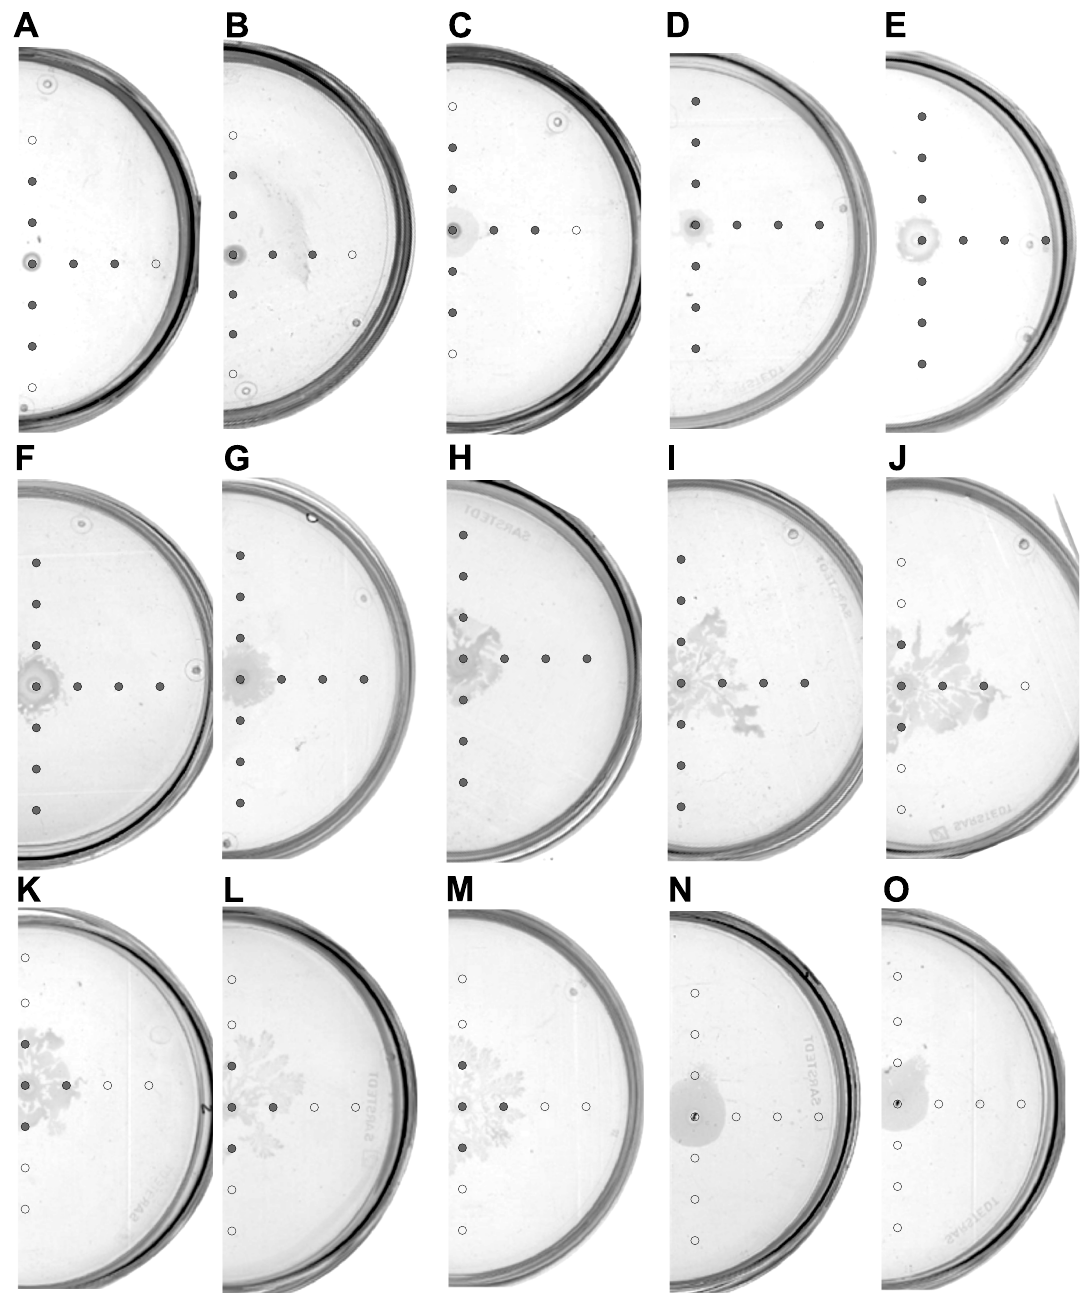
Fig 4. Swarming and AHLs production by Dickeya solani IFB102 on plates with B-medium containing 0.5% of agar and the following concentrations glucose: (A) 0%, (B) 0.01%, (C) 0.02%, (D) 0.1%, (E) 0.25%, (F) 0.3%, (G) 0.4%, (H) 0.5%, (I) 1%, (J) 1.5%, (K) 2%, (L) 2.5%, (M) 3%, (N) 4%, (O) 5%. Swarming assays were performed for 24 h. Grey circles represent spots at which AHLs were detected. Open circles represent spots at which no AHLs were